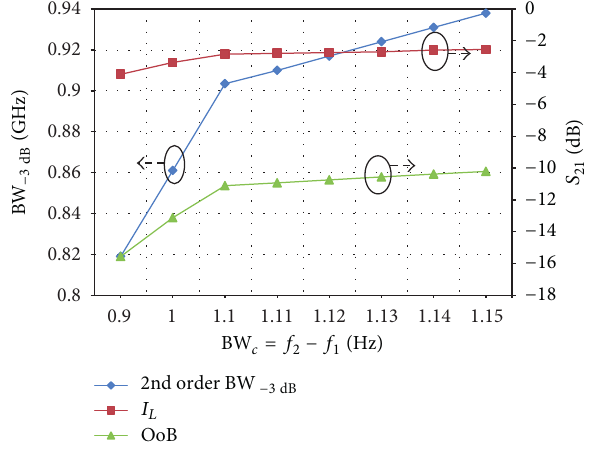
Figure 4: Effect of varying the 𝑓 1 and 𝑓 2 .